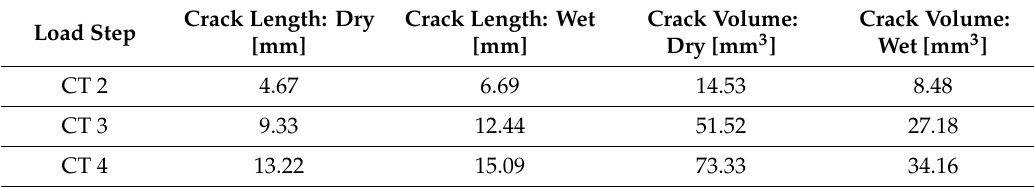
Figure 10. Comparison of the crack-shape based on the differential tomography for both dry and wet specimens in the post-peak softening phase. Table 2. The crack length and the crack volume of the dry and wet specimen.